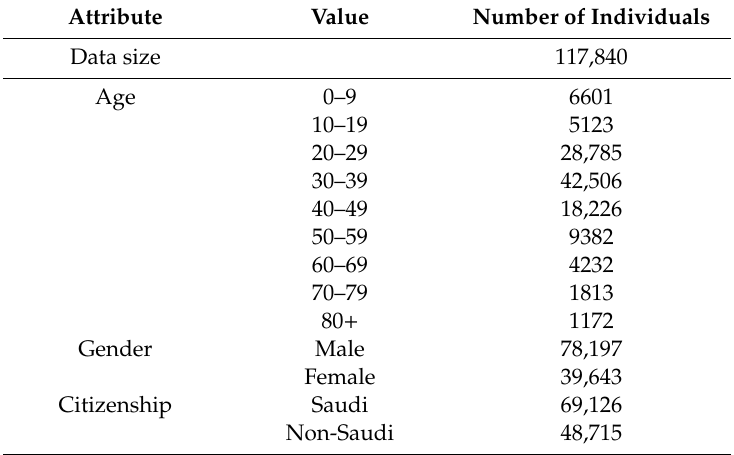
Figure A2. Ratio of individuals per value of all attributes of the COVID-19 patient dataset (patient records from 2 March 2020 to 25 April 2020). Table A2. Attributes of the COVID-19 patient dataset (patient records from 2 March 2020 to 25 April 2020).